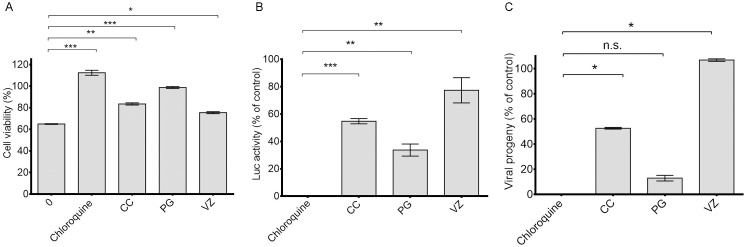
Comparative effect of the essential oils on HEK293T against RRV.Viability of HEK293T cells infected with RRV-T48 (MOI 2) upon treatment with chloroquine at the concentration 20 μg.mL-1and essential oil at the concentration 1× CC10 at 24 h post-infection (A); Inhibition of RRV-renLuc replication at MOI 2 using co-treatment of chloroquine at the concentration 20 μg.mL-1and essential oil at the concentration 1× CC10 (B); Viral growth by plaque assay on Vero cells (C). Controls are RRV-infected cells without treatment by chloroquine and the essential oils. Values are expressed as mean ± SEM (n = 5). (*p < 0.05, **p < 0.01, ***p < 0.005).